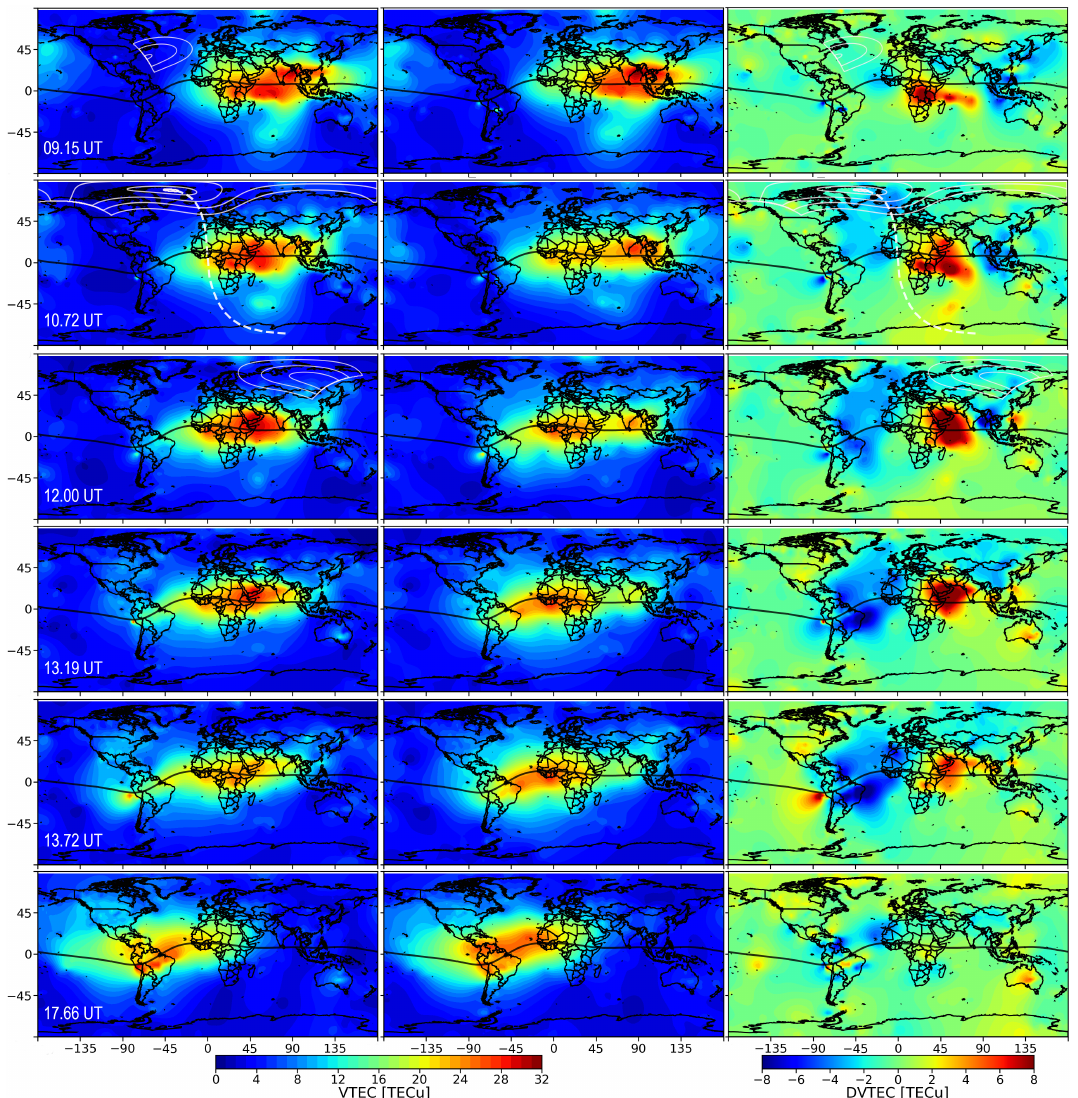
Figure 3. Ionospheric TEC maps during the 10 June 2021 Annular Solar eclipse using the Kriging interpolation method. From left to right panels: VTECe, VTEC , and DVTEC[TECu]. From top to bottom panels: 09.15 UT, 10.70 UT (GE time), 12.00 UT, 13.19 UT (P4 time), 13.72 UT, and 17.66 UT. Eclipse obscuration masks from 20% obscuration and with intervals of 20%, at 350 km altitude (white line) are shown. The white dashed line starts from the maximum obscuration of the solar eclipse to its conjugate location in the Southern Hemisphere at 350 km